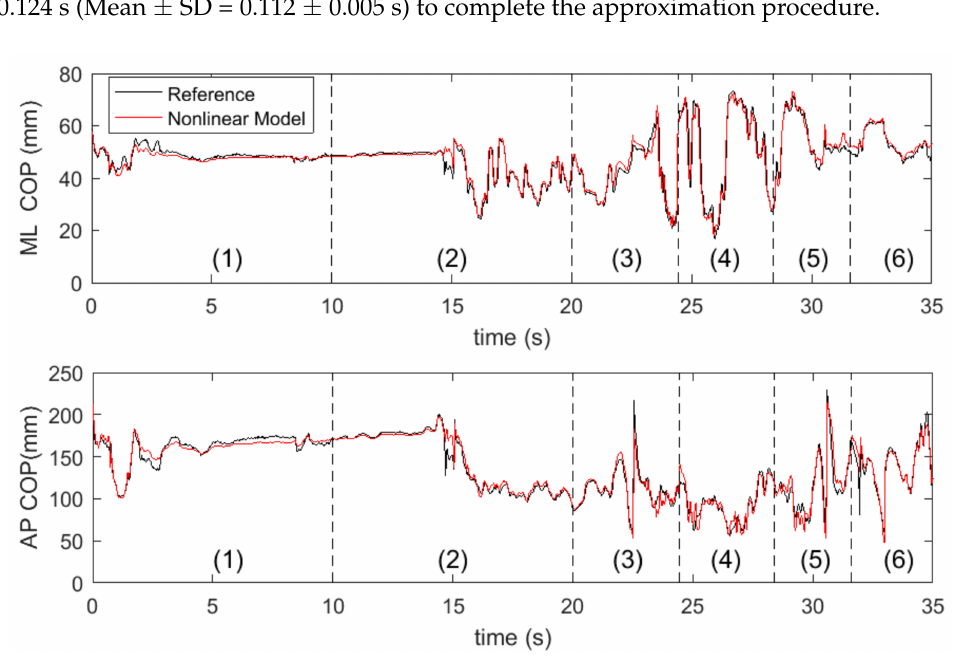
Figure 6. Representative plot of the comparison of COP trajectory estimation by the nonlinear model and the reference data. The data were obtained from the left foot and for the different tasks: (1) quiet standing with open eyes, (2) quiet standing with closed eyes, (3) standing up from a chair with armrests, (4) sitting down to a chair with armrests (task 3 and 4 have multi-contacts phases where participant’s hands are in contact with armrests or the seat) (5) standing up from a chair without armrests, and (6) sitting down to a chair without